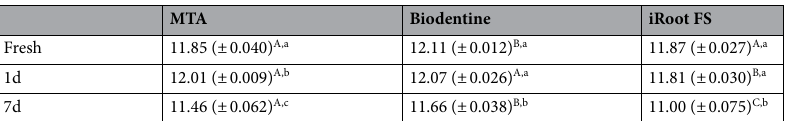
Table 1. The pH values of MTA, Biodentine, and iRoot FS leachates at different time intervals (mean ± S.D.;n = 3). Superscript capital letters represent statistically significant differences in the same row, and superscript lowercases indicate statistically significant differences in the same column. The same letters indicate no significant differences among the compared groups ( p > 0.05) and vice